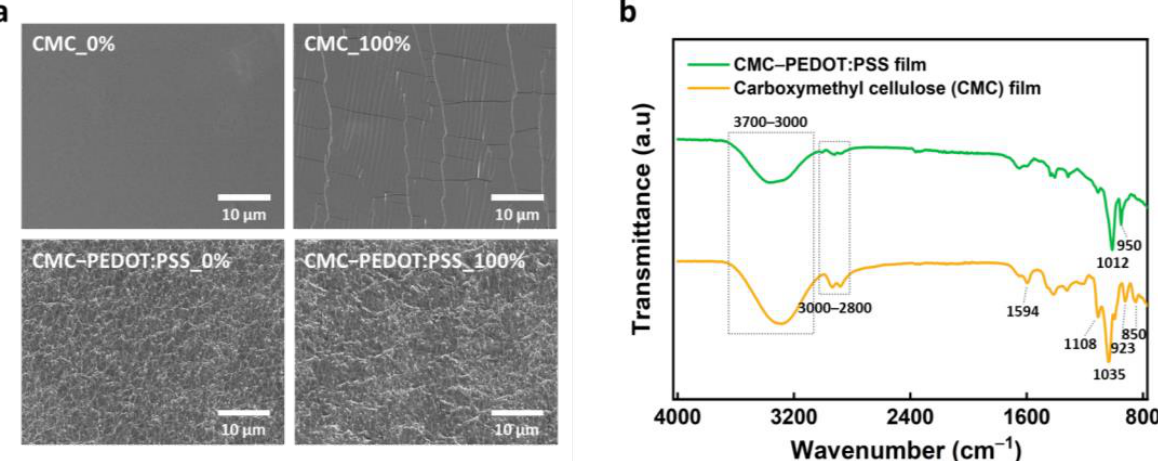
Figure 3. ( a ) SEM images of CMC and CMC-PEDOT:PSS films under strain of 0% and 100%. ( b ) FTIR spectra of CMC and CMC-PEDOT:PSS films.